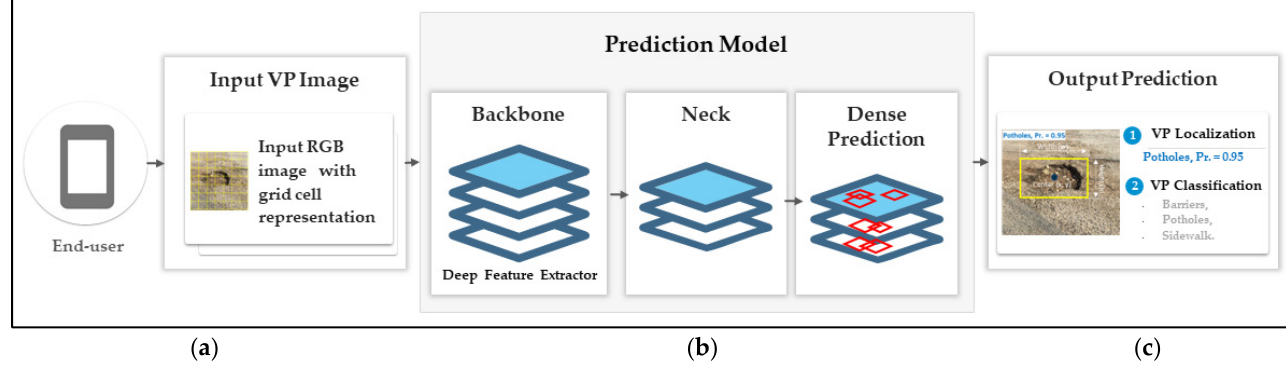
Figure 3. Abstract view of the proposed visual pollution predictor (VPP) framework based on the YOLOv5 predictor. The process consists of three steps: ( a ) feeding an input image, ( b ) using a YOLO prediction model, and ( c ) outputting a prediction with localization and classification.